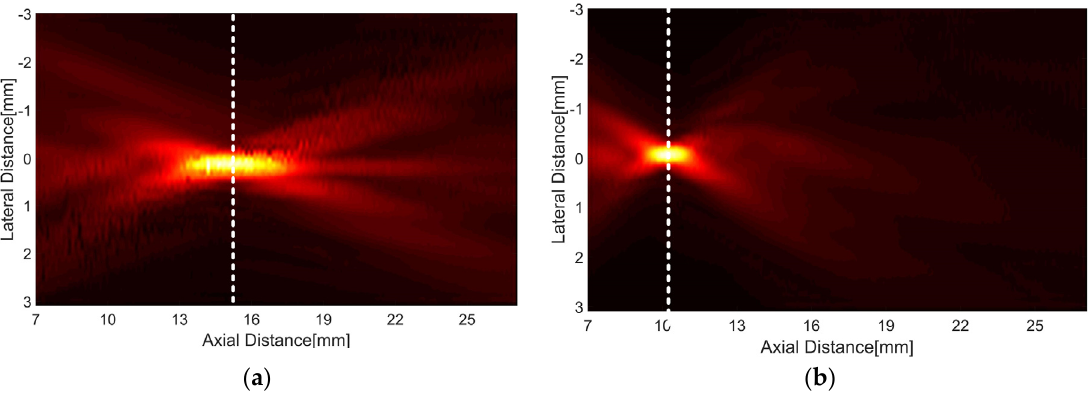
Figure 10. One-way radiation patterns of the press-focused transducer ( a ) and the double-focused transducer ( b ), which were measured by a hydrophone. The white dashed line indicates the depth at which the maximum pressure occurred.